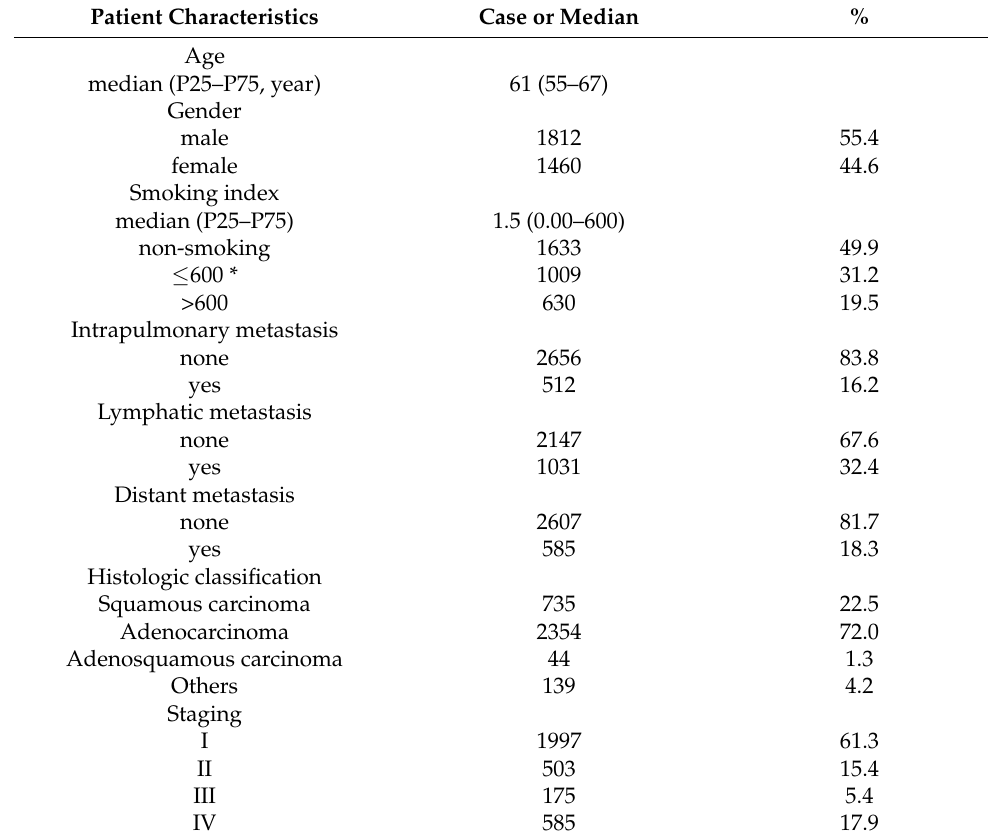
Table 1. Basic information of the patients with NSCLC.